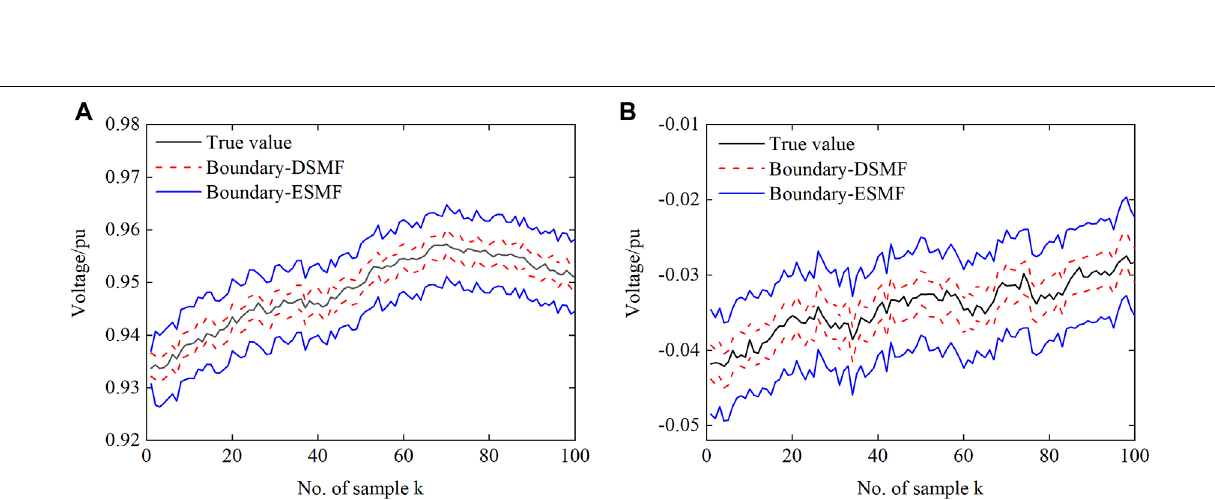
FIGURE 7 | Boundaries between the true and estimated values of a-phase at bus 4: (A) the real part of the voltage and (B) the imaginary part of the voltage.